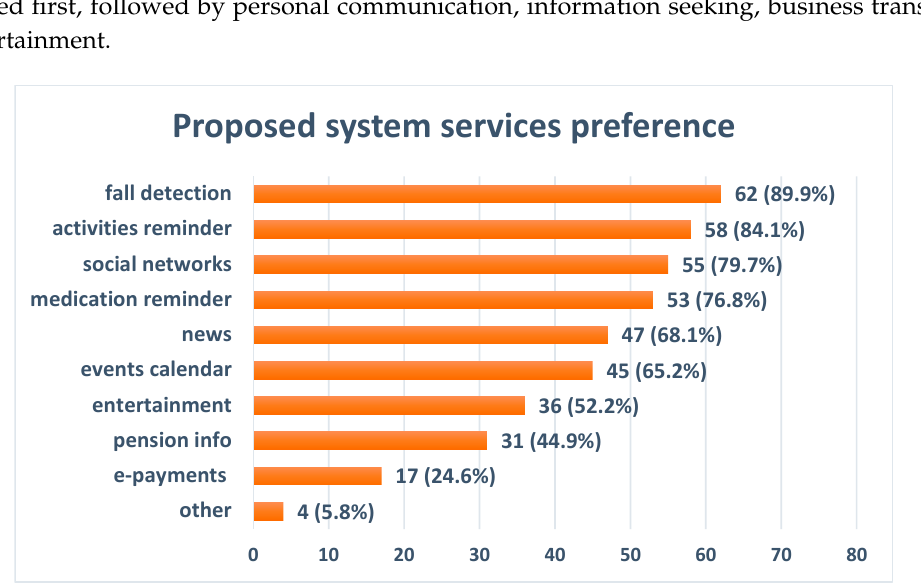
Figure 3. Expressed preference on the proposed services.